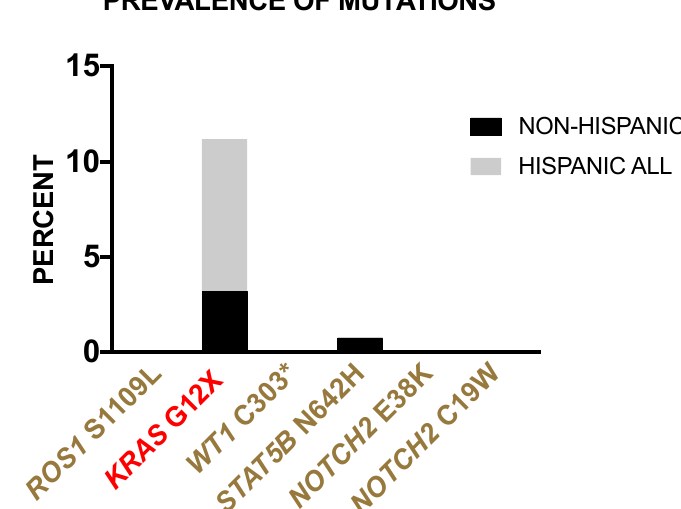
Figure 4. Prevalence of borderland tier mutations in Hispanic and non-Hispanic ALL patients from the TARGET-ALL Phase II database. Variants classified as Tier 1 (red) and Tier 3 (gold) are shown with their frequency in percent (superimposed bars) across Hispanic ALL patients (light gray) and non-Hispanic patients (black) from the TARGET-ALL Phase II database.